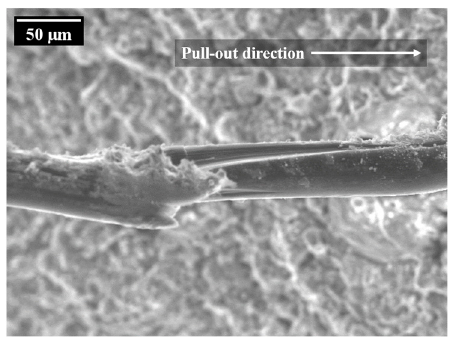
Figure 11. Probable locking front at a PVA-fibre after quasi-static pull-out [40].